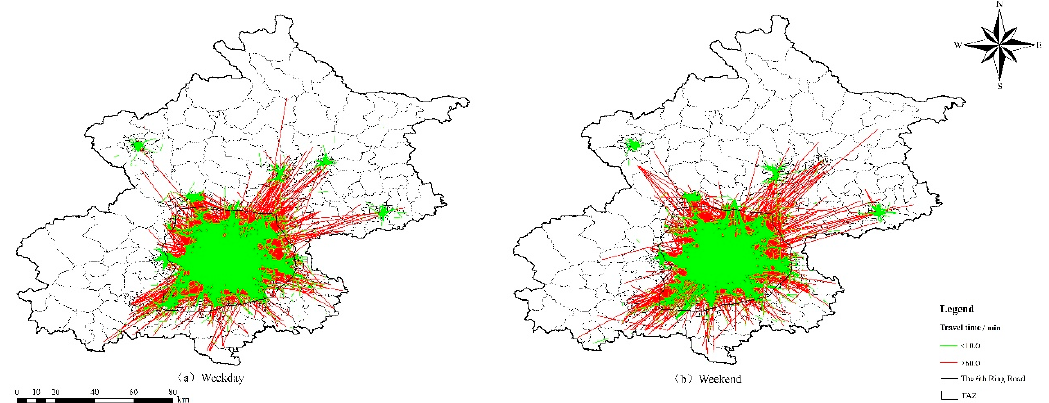
Figure 9. Distribution of travel intensity in Beijing based on the TAZ scale.